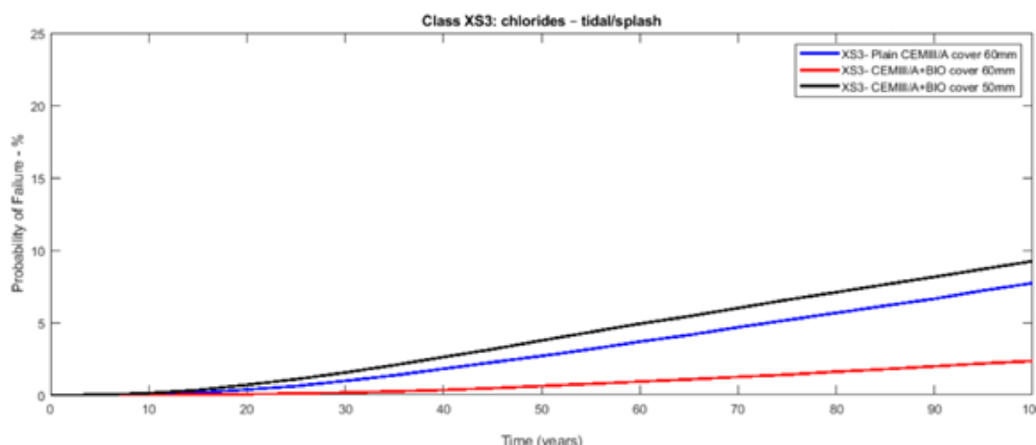
Figure 5. Probabilistic service life results of CEM I 52.5N concrete — exposure class XS2 (submerged) — without and with bioproduct for a cover of 60 and 50 mm.